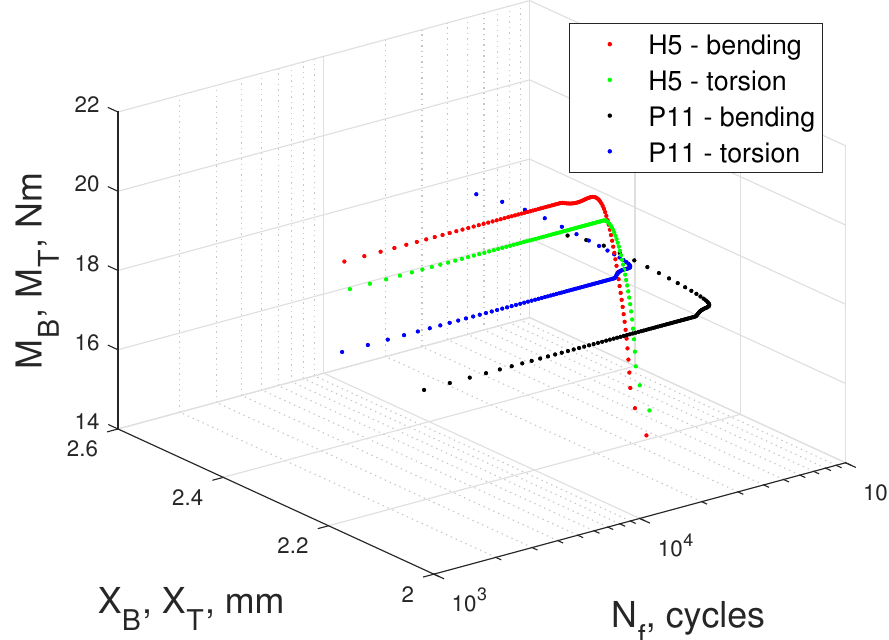
Figure 16. Change in recorded values of bending and torsional moments of specimen No. H5 during the entire test period under kinematic load (red and green) and change in the value of the machine lever displacement for dynamic load for specimen no. P11, black and blue.